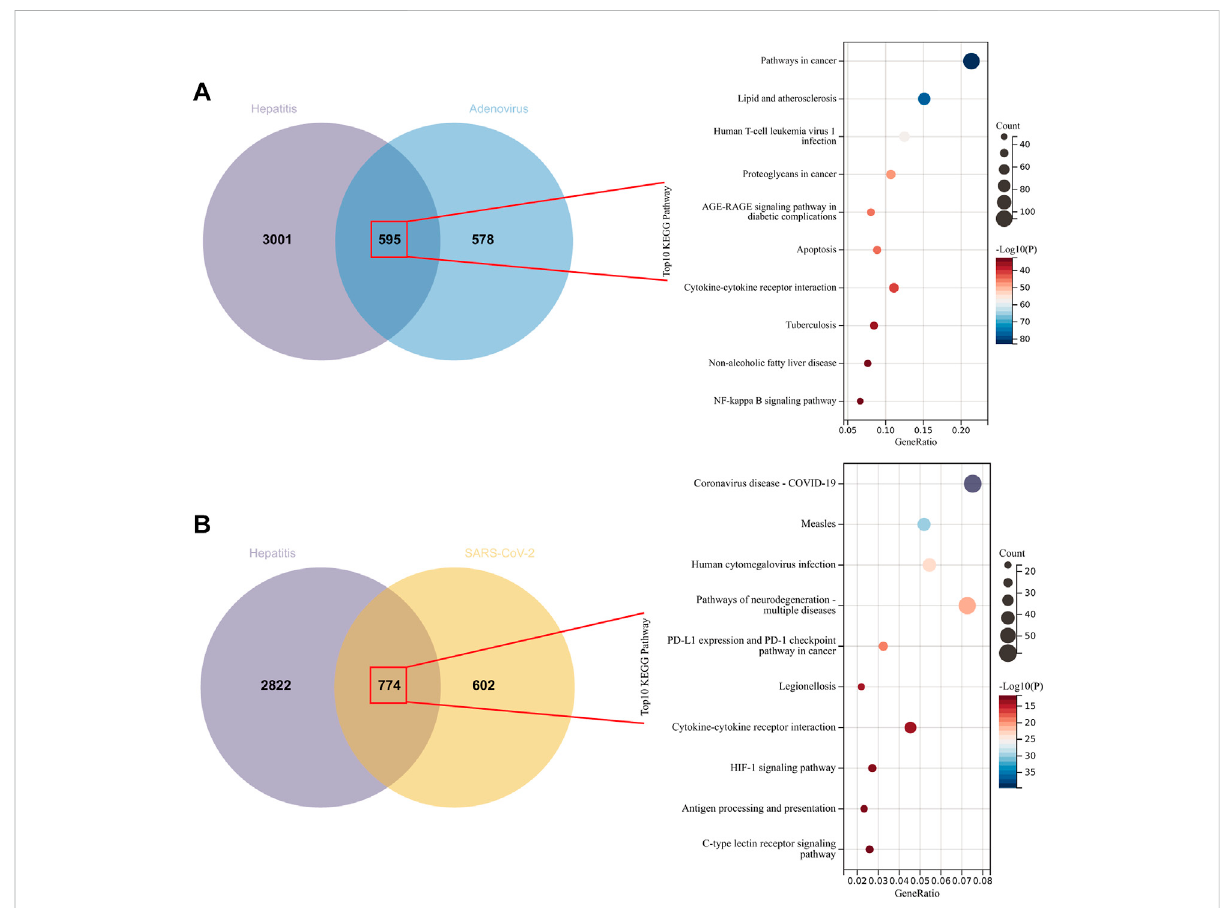
FIGURE 3 Intersection genes between hepatitis and adenovirus/SARS-CoV-2. (A) Venn diagram representing the 595 intersecting genes of hepatitis with Adenovirus (left). Kyoto Encyclopedia of Genes and Genomes (KEGG) analysis revealed that they are related to liver metabolism, viral infection, receptor interaction, and immune-in fl ammatory response (right). (B) Venn diagram representing the 774 intersecting genes of hepatitis with SARS- CoV-2 (left), and they enriched in viral infection, receptor interaction, and immune-in fl ammatory response